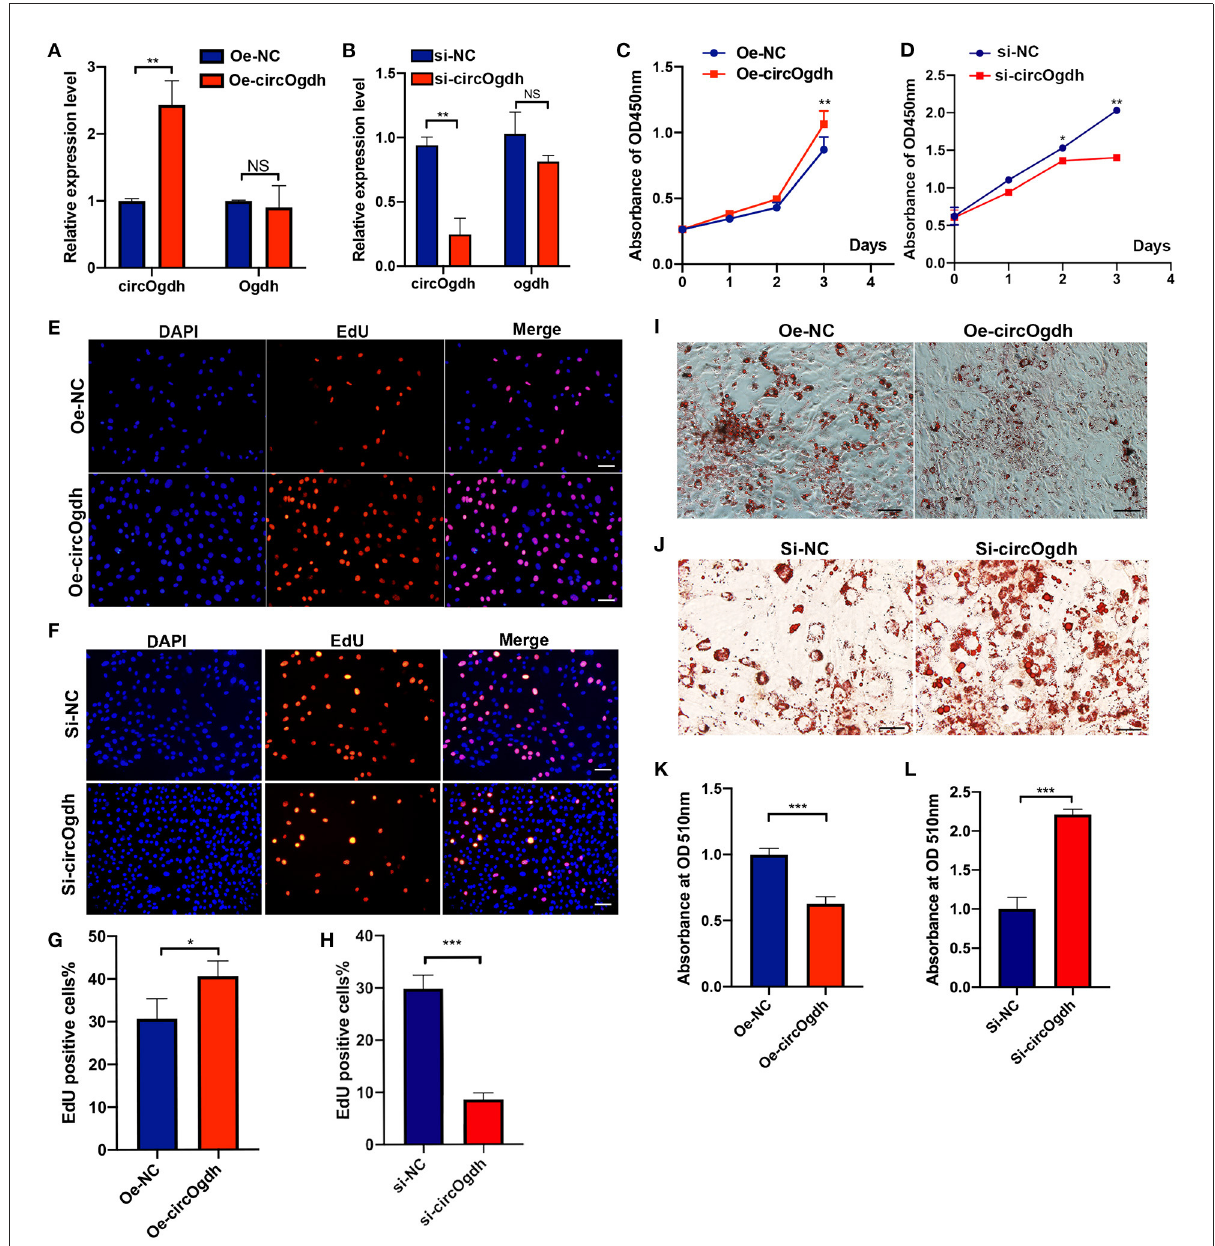
FIGURE7 CircOgdh promotes brown fat proliferation and reduces lipid droplet accumulation. (A,B) After transfection with Oe-NC, Oe-circOgdh, si-NC, and si-circOgdh in brown adipocytes, RT-qPCR was adopted to detect the levels of circOgdh and Ogdh expression. (C,E,G) CCK8 and EdU staining were also performed to evaluate the proliferative capacity of BAT cells under circOgdh overexpression, (D,F,H) , and to determine the effect of circOgdh knockdown on cell proliferation. Scale bar, 20 µ m. (I,J) Oil Red O staining was performed to assess adipogenic differentiation of brown adipocytes. Scale bar, 20 µ m. (K,L) The extracted Oil Red O dye was quantified based on the absorbance values at 510nm. Values in (C,D,G,H,K,L) are means ± SEM ( n = 3), * P < 0.05, ** P < 0.01, *** P < 0.001, NS, Not Statistically Significant.